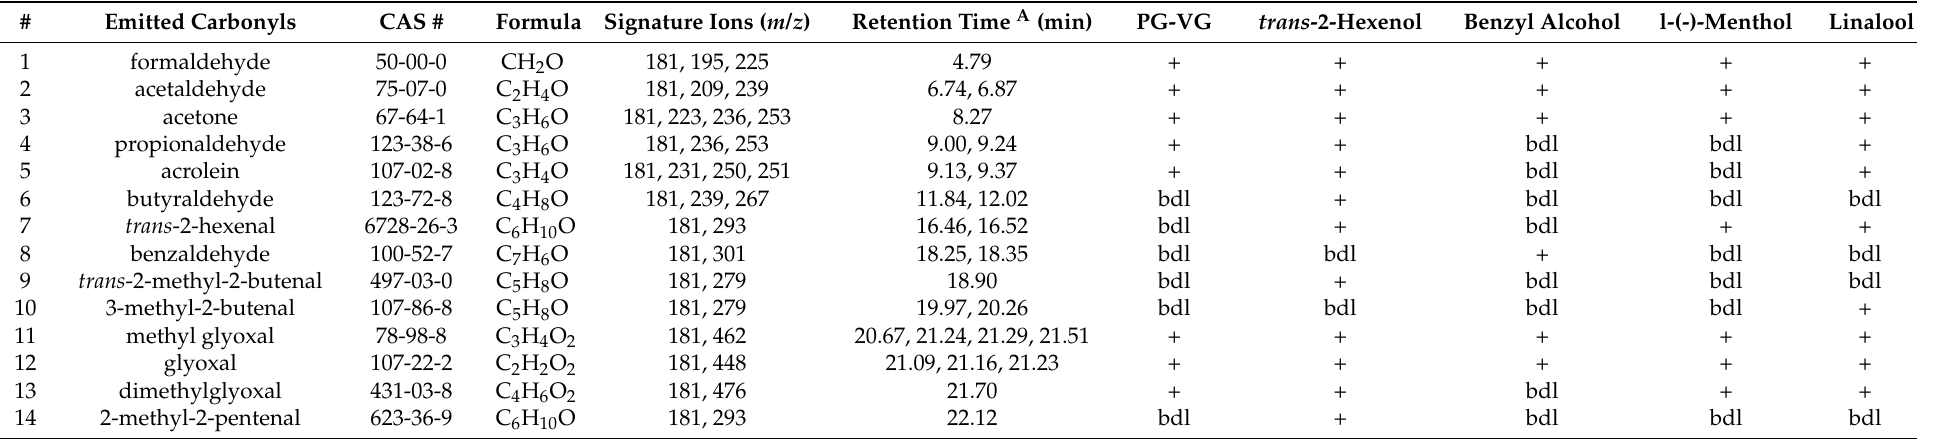
Table 1. Emitted carbonyls identified in vaping emissions of PG-VG and four flavored e-liquids. The signature ions ( m / z ) of carbonyl-PFBHA oxime derivatives were used to characterize carbonyl identities in Figure